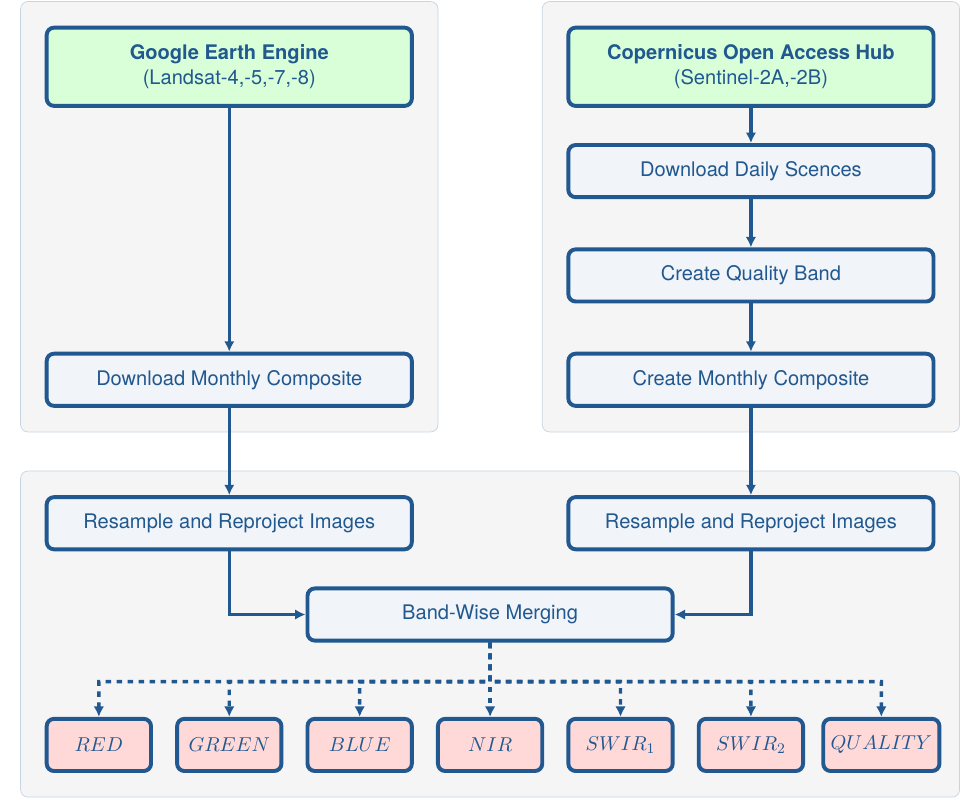
Figure 3. Flowchart of the